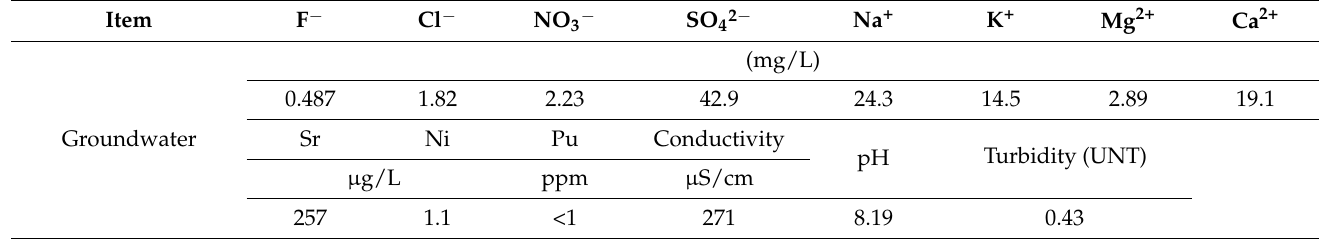
Table 4. Analysis results of